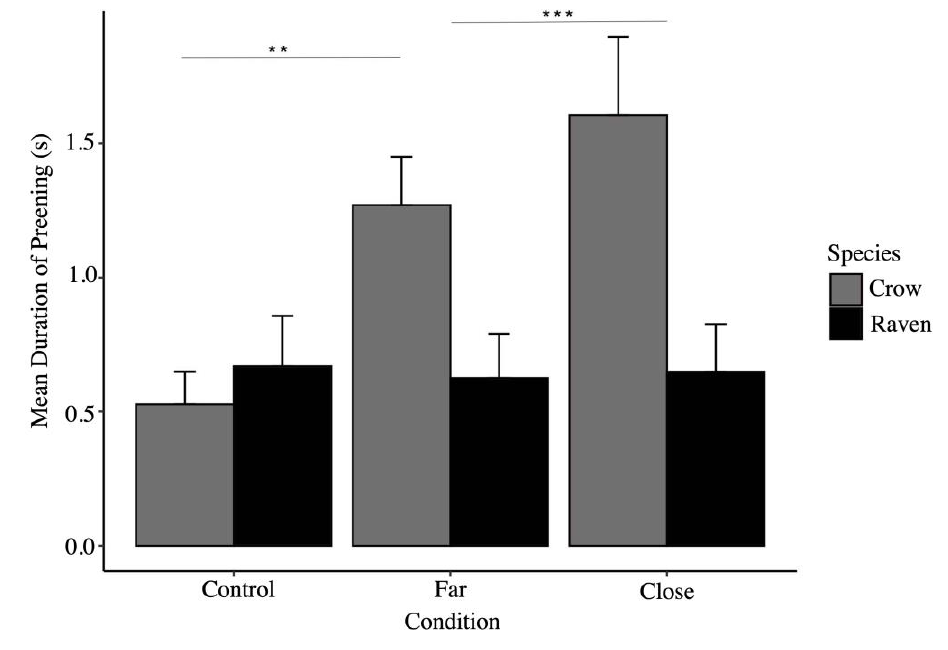
Mean Duration and Standard Error of Preening in Seconds per Visitors’ Condition in Crows (Grey) and Ravens (Black)